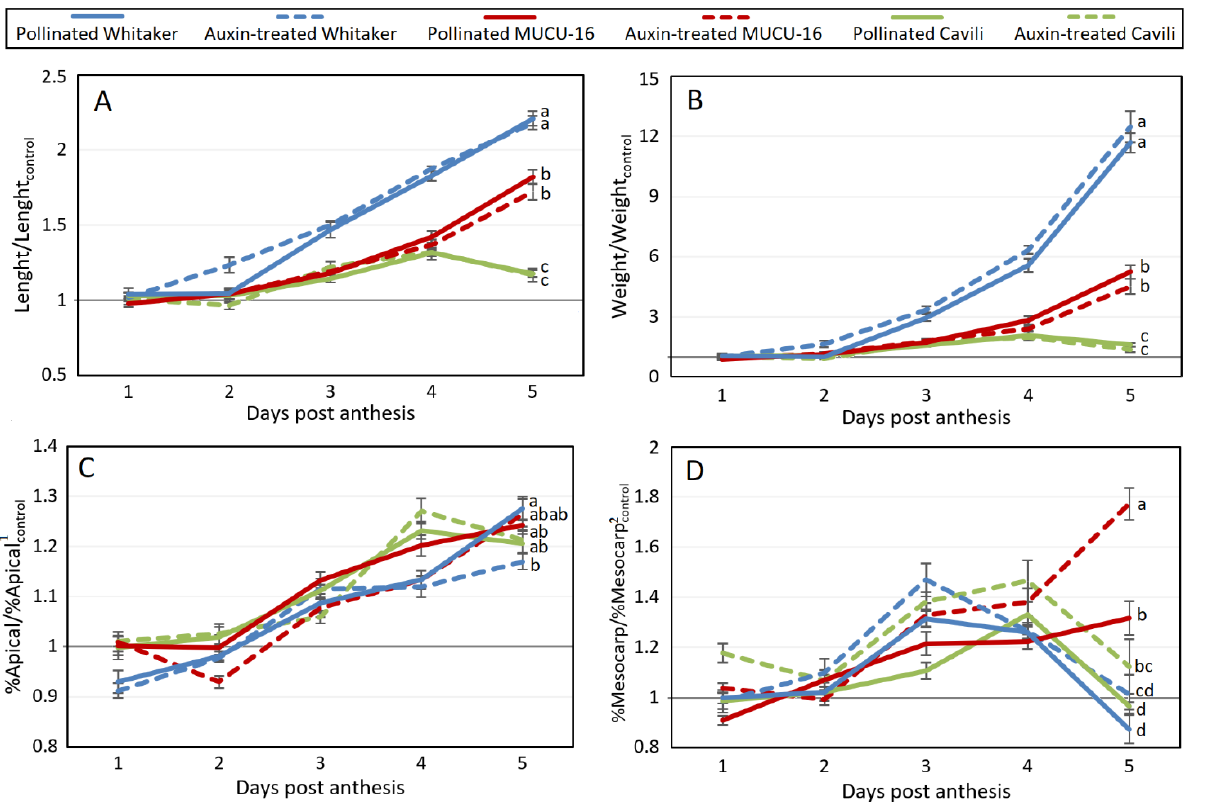
Figure 2. Fruit morphological changes versus non-treated fruits. Length ( A ), Weight ( B ), Apical shape ( C ) and Mesocarp width ( D ) of the auxin-treated (A) and pollinated (P) fruits compared with the non-treated fruits, in the Whitaker (W), MUCU-16 (M) and Cavili (C) genotypes for 5 dpa. 1 %Aplical (cm apical /cm central ). 2 %Mesocarp (cm mesocarp /cm central ). The line corresponded with the non-treated control value of each sample. Significative differences 5 dpa (ANOVA p < 0.05) are indicated with letters (Tukey HSD). Error bars are standard errors (n ≥ 8).